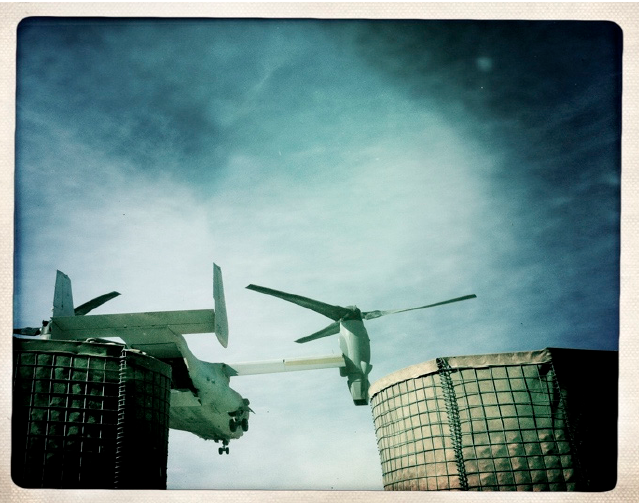
Figure 7. The Drone. Source: created by Rita Leistner (used with photographer’s permission).